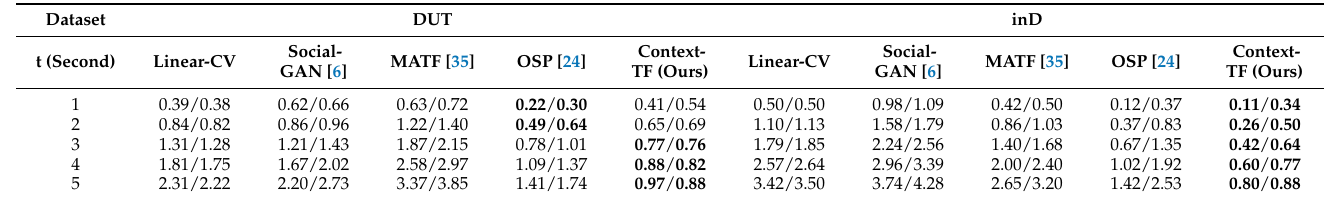
Table 3. The performance of our proposed Context-TF in comparison to baseline approaches from the literature. The reported scores are shown according to the evaluation metrics (ADE/RMSE) over five different prediction horizons. Lower scores are